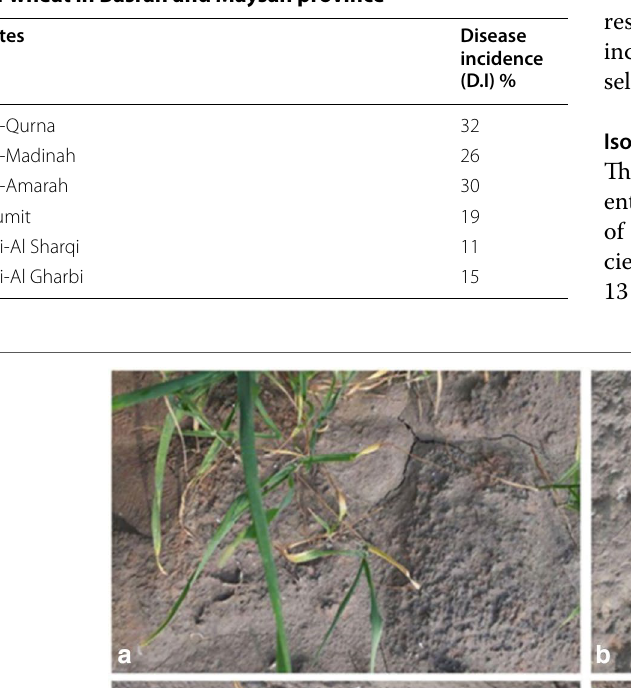
Table 1 Percentage of damping-off disease incidence